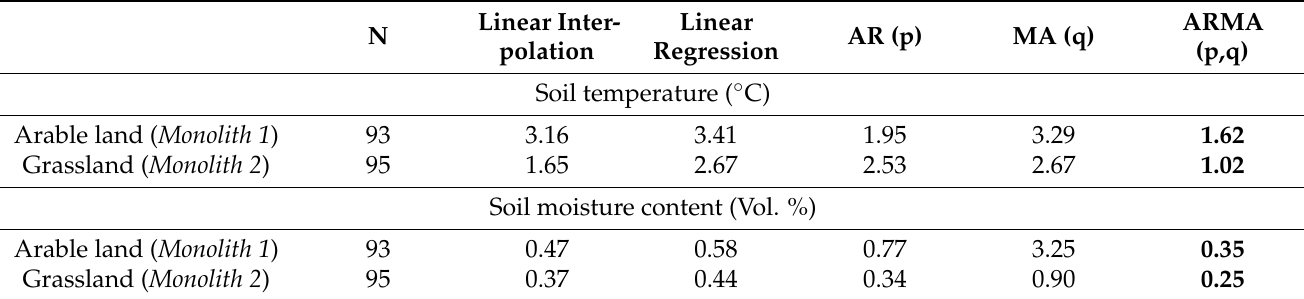
Table 4. The mean absolute percentage error (MAPE) of the missing values estimations via different methods depending on the land use, measurements at the 30 cm depth; mean (%). N